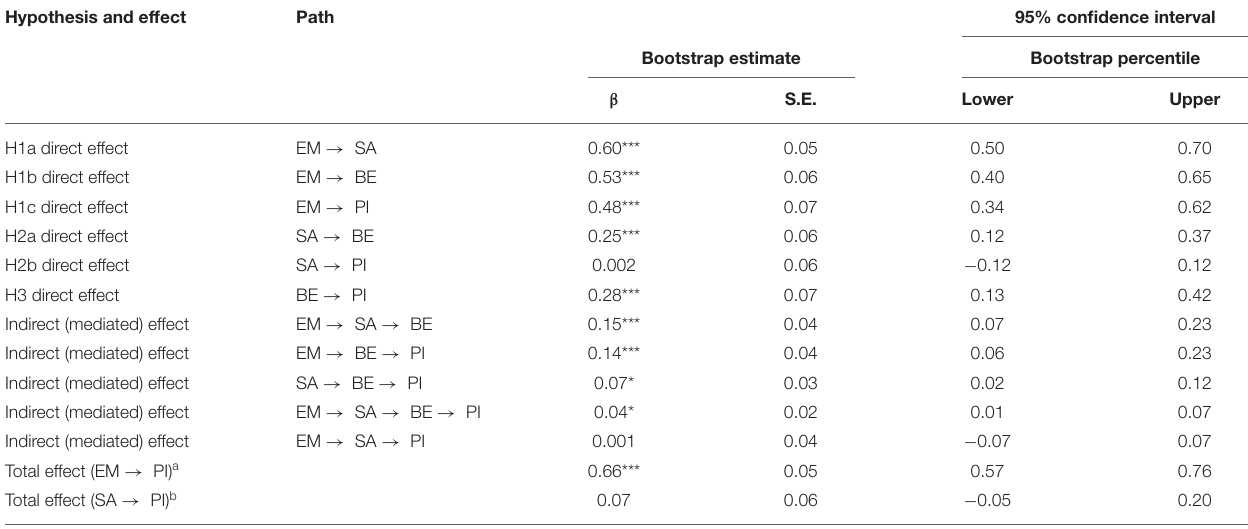
TABLE 4 | Hypothesis testing results and the direct, indirect, and total effects in the model. Hypothesis and